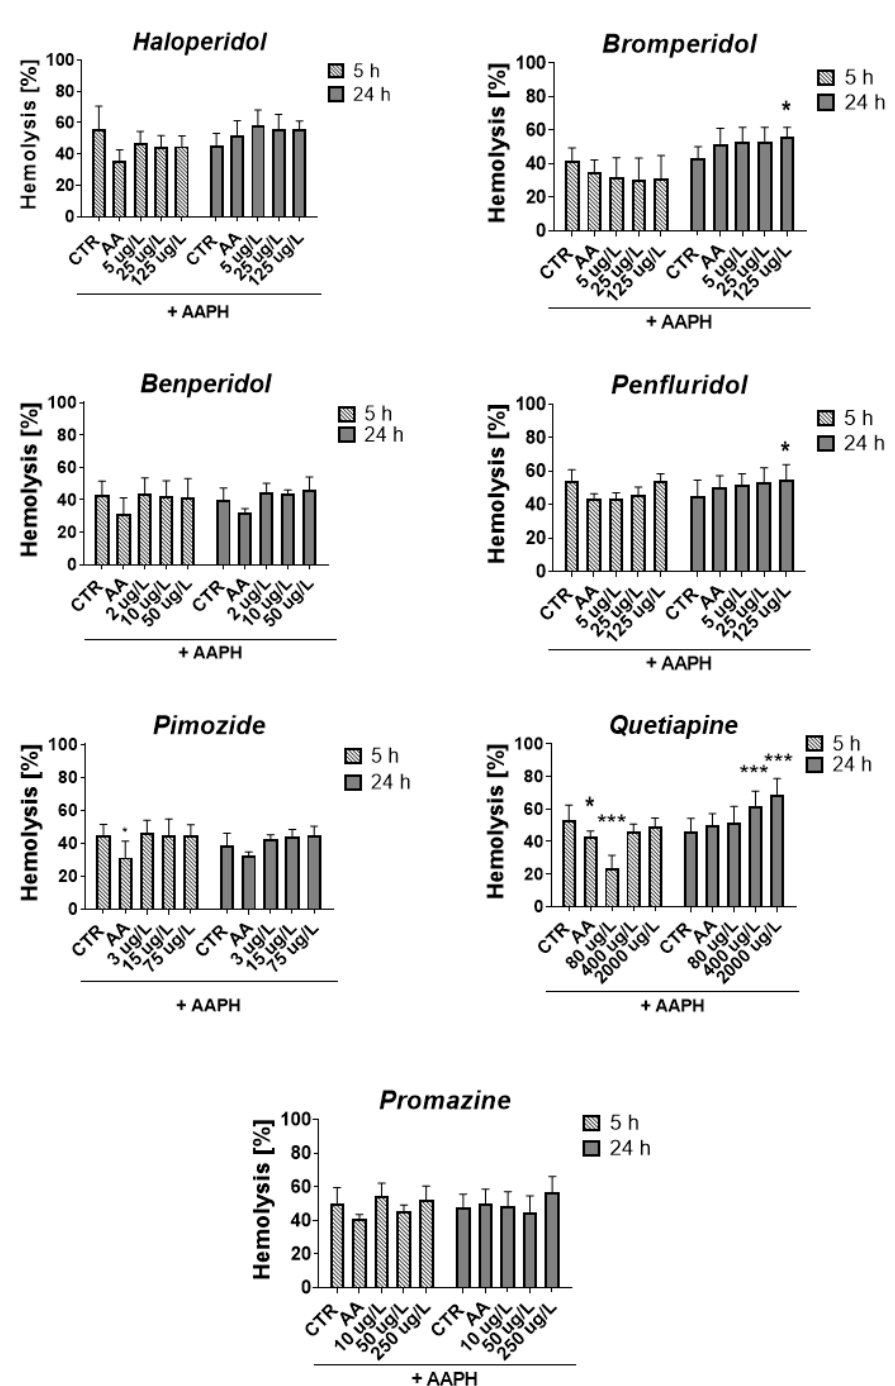
Figure 7. Effect of tested antipsychotics at 1/5 × TPC max , TPC max and 5 × TPC max on erythrocyte hemolysis measured after 5 h and 24 h of incubation at 37 °C. Results are presented as mean ± SD, n = 4–12. * p < 0.05, *** p < 0.001 vs. control (samples with AAPH). After 5 h, all compounds slightly reduced or did not contribute to the lysis of RBCs, except for quetiapine at a concentration of 80 µ g/L, which produced a statistically signifi- cant decrease in RBCs hemolysis compared with the control with AAPH (23.9% vs. 53.4% for AAPH control, p < 0.001). The opposite effect was produced after 24 h of incubation, in which enhanced hemolysis was observed (51.9% vs. 45.9% for AAPH control, p > 0.05).